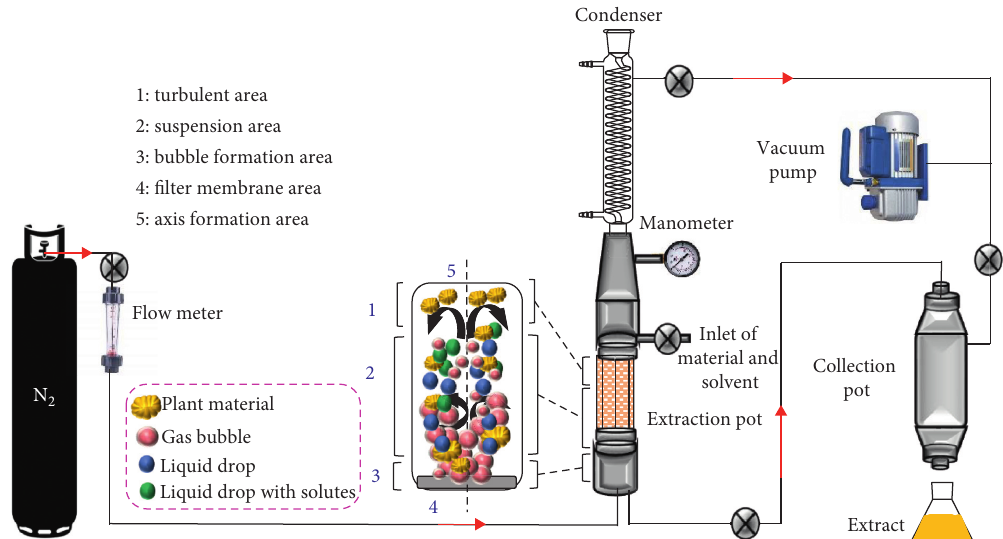
Figure 8: General scheme of a NPCE